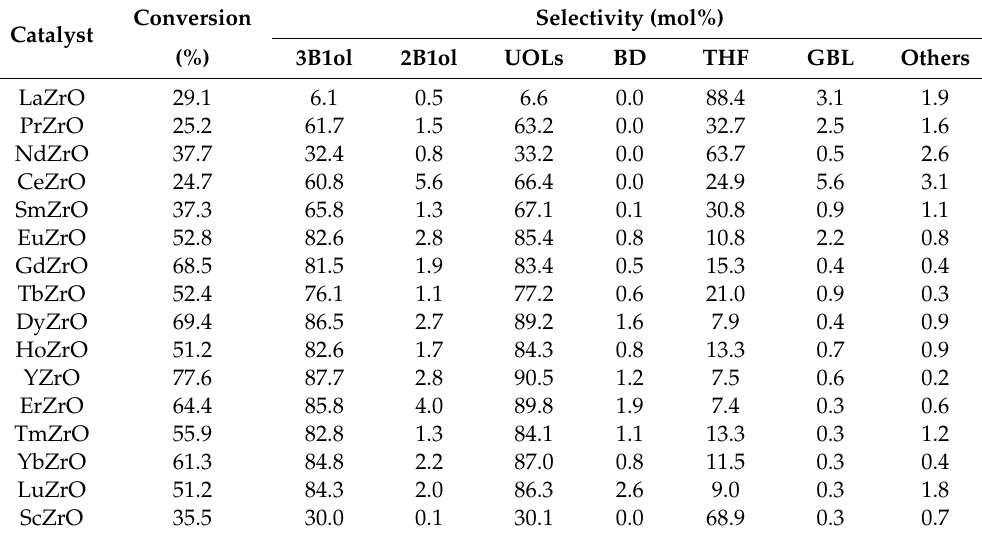
Table 2. Dehydration of 1,4-BDO over REZrO catalysts calcined at 900 ◦ C. Catalyst